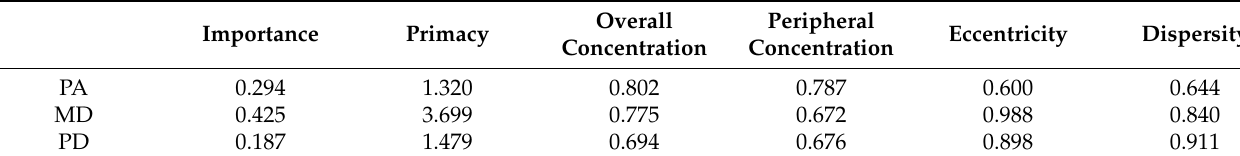
Figure 7. Dendrogram of cluster analysis. Table 4. Centers of the three clusters.